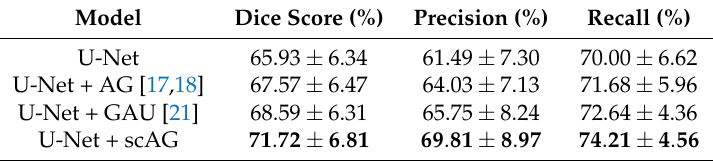
Table 8. Performance on the CVC-ClinicDB dataset using other attention gates (best results marked